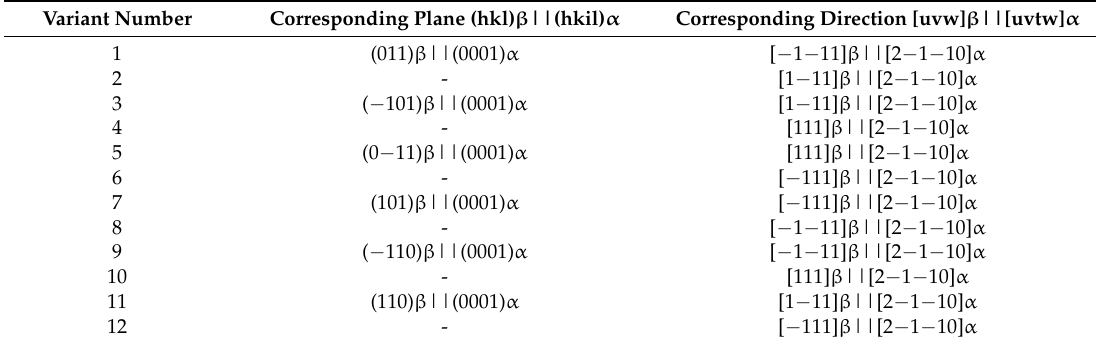
Table 2. Orientation variants resulting from the β → α phase transformation according to Burgers relationship.